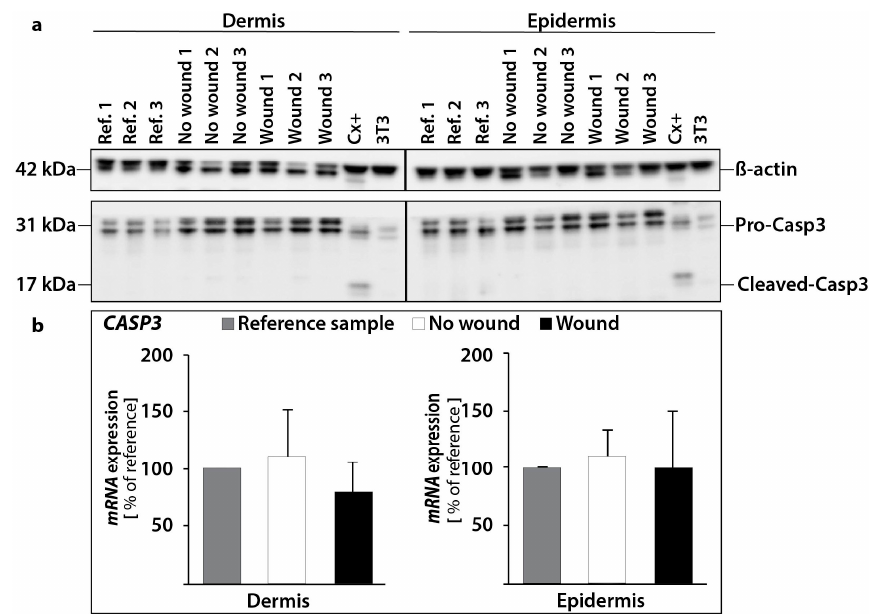
Figure 6. Investigation of caspase-3: changes in the protein content of pro-caspase-3 and cleaved caspase-3 ( a ). The amount of protein was investigated in reference controls (0 d), non-wounded and wounded samples. As a positive control for apoptosis CX+ cells were utilized. 3T3 protein was used as a cytoskeletal control. β -actin (loading control), pro-caspase-3 and cleaved caspase-3 were investigated independently in dermal and epidermal tissue for the same skin samples. Quantitative real-time PCR of CASP3 gene expression revealed no changes ( b ).